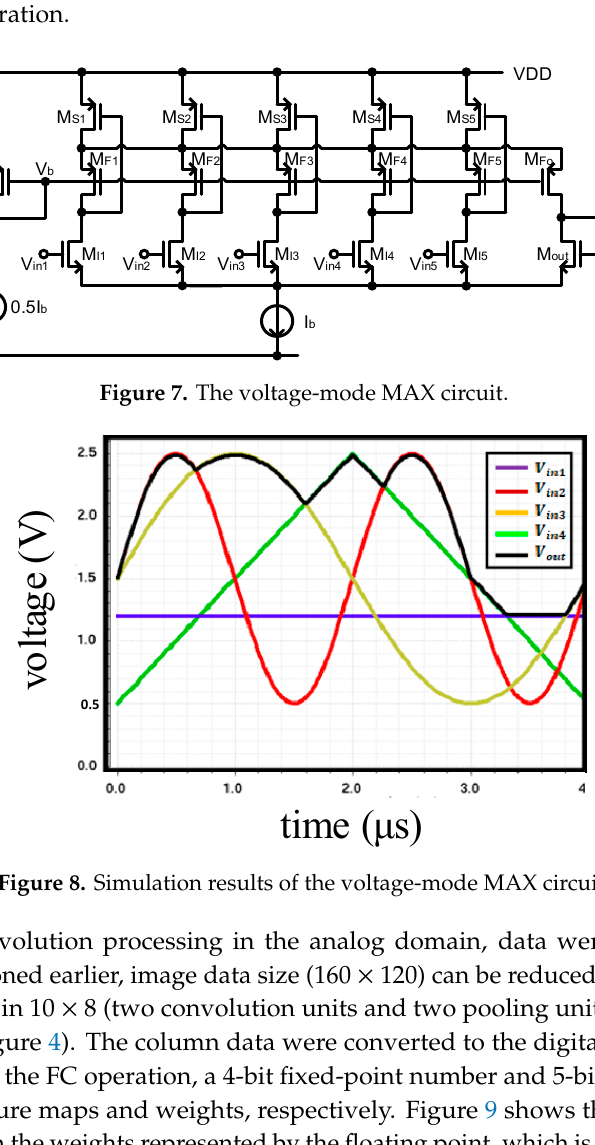
Figure 9. Block diagram of the fully connected layer.